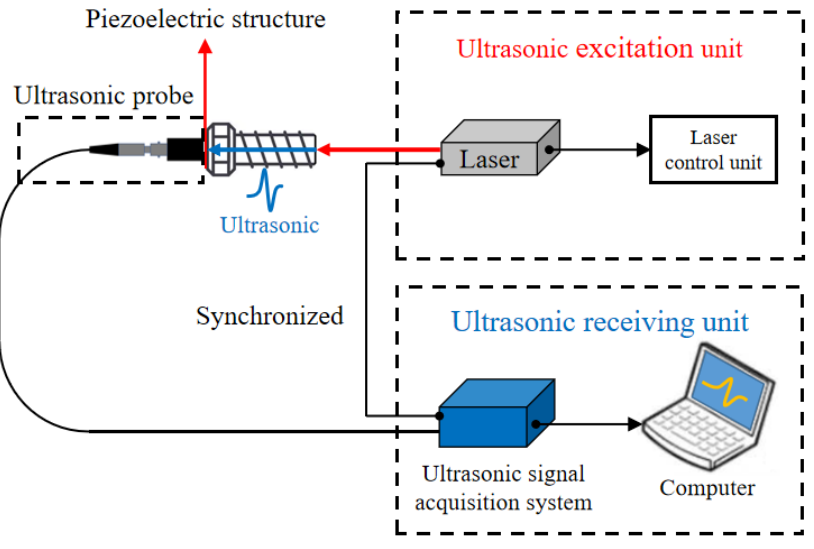
Figure 2. Schematic diagram of the laser ultrasonic system for bolt preload force evaluation.